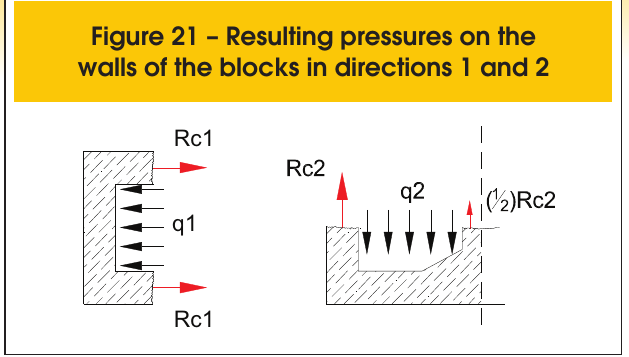
Figure 21 – Resulting pressures on the walls of the blocks in directions 1 and 2